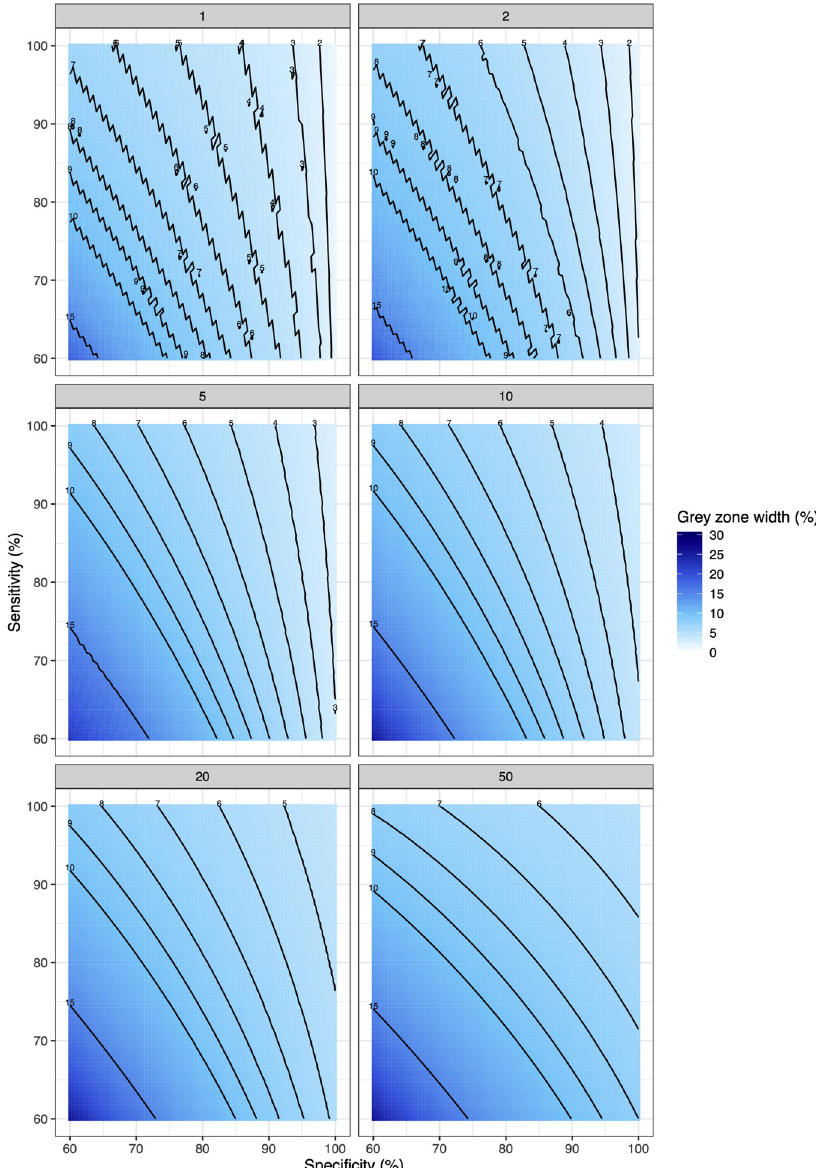
Fig 6. The width of grey zones around 6 program decision thresholds for 1,168 theoretic diagnostic tests. These contour plots illustrate the width of the grey zone for each of the unique combinations of sensitivity and specificity when decision making is adequate ( ε � 25% and ε � 5%), each line representing the same width of grey overtreat undertreat zone. The number beside the line represents the floor value of the width of the grey zone in % (e.g., any value � 10% and < 11% is set at